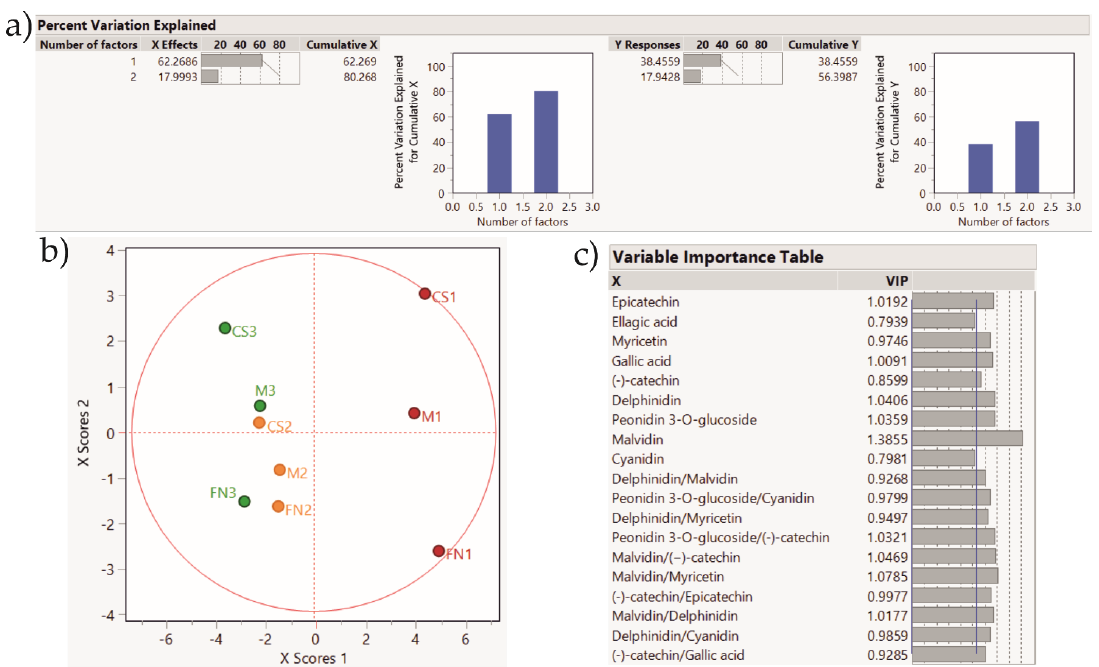
Figure 6. PLS-DA score plot showing sample clustering for Stage 1 wines. Color coding: red—Murfatlar 2014; orange— Murfatlar 2015; green—Valea Călugărească 2015. ( a ) Percent of variation explained by the two factors; ( b ) PLS-DA score plot; ( c ) VIPs (Variable Importance for the Projection) showing the predictors and their importance in determining the PLS projection model.